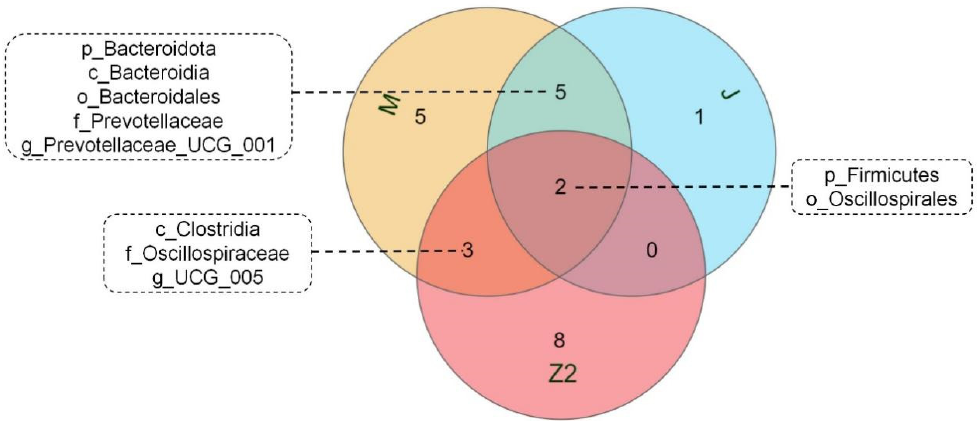
Figure 3. Venn diagram of differential biomarkers based on LEfSe analysis in cecum, colon, and rectum.